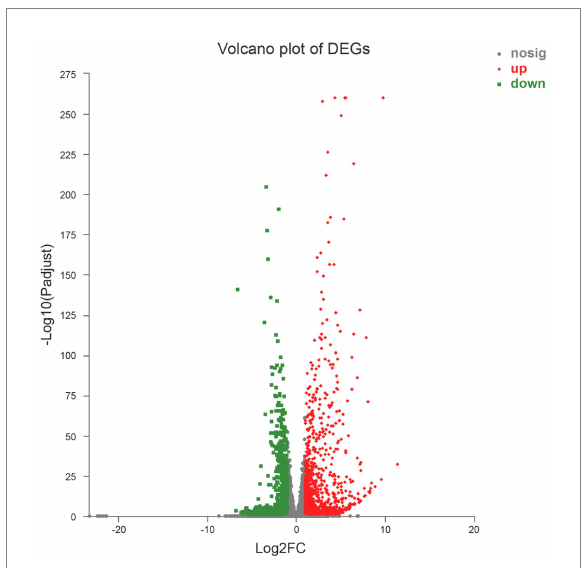
FIGURE 2 Volcano map of 1,839 differentially expressed genes.